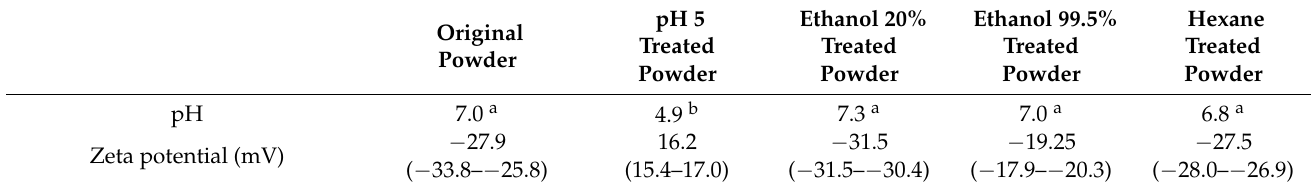
Figure 7. Water holding capacity (OHC) before and after treatments in cricket powder. Letters represent significant difference ( p < 0.05). a = ethanol 99.5% vs. original powder, pH 5, and ethanol 20%. b = hexane vs. original powder, pH 5, and ethanol 20%. Table 2. pH and zeta potential of the